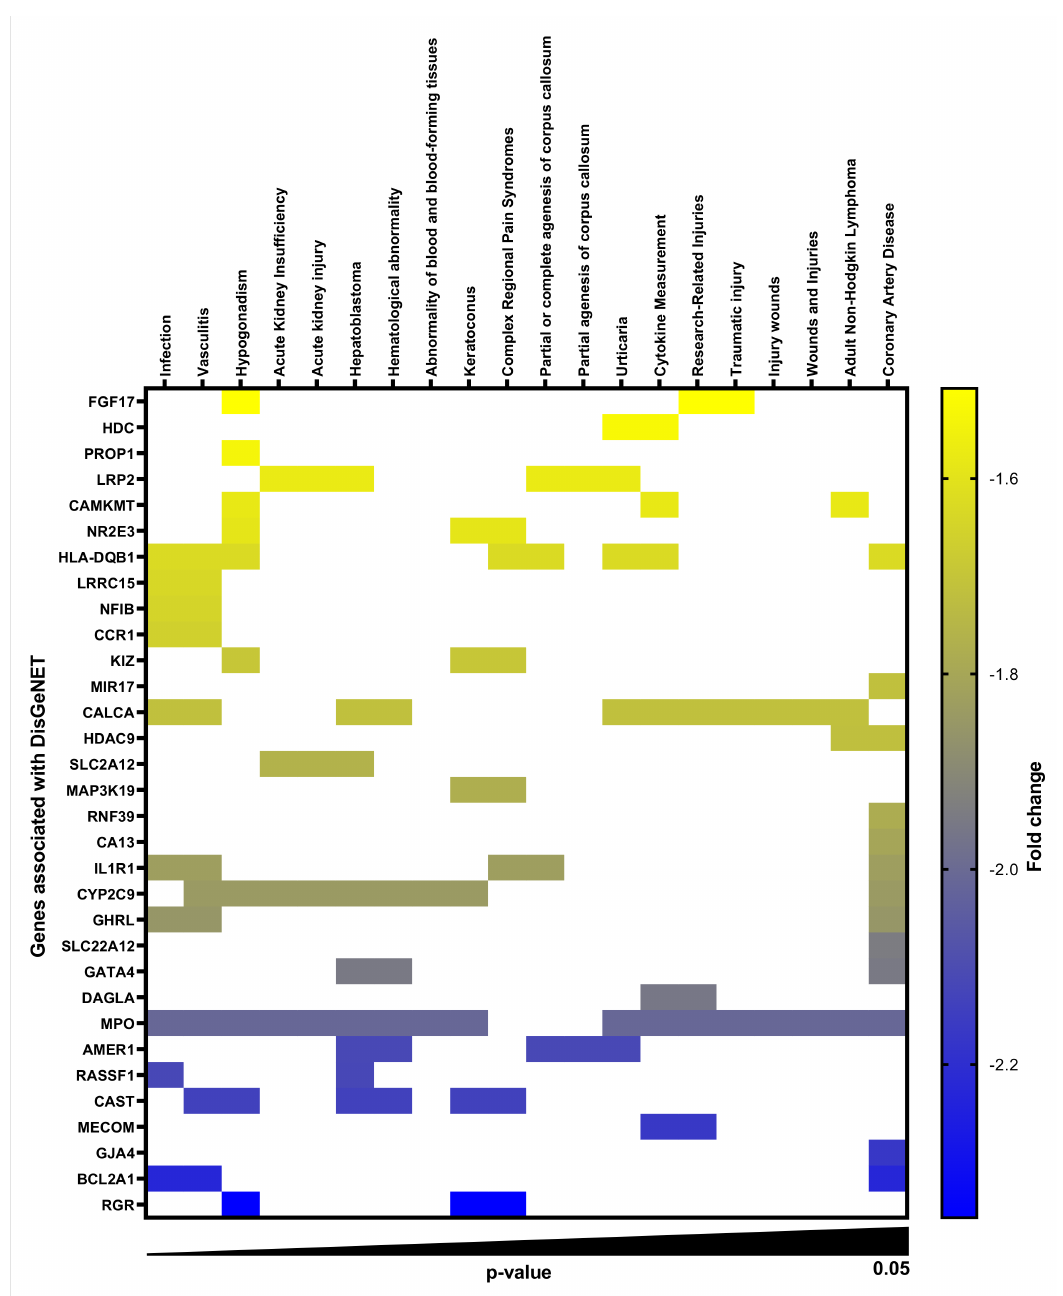
Figure 1. TMAO-downregulated genes in proximal tubular cells with DisGeNET association. Heat map showing the gene-disease association ( p < 0.05) profile of 32 significantly downregulated genes (fold change ≥ 1.5) in proximal tubular cells after 6 h of TMAO 300 µ M stimulation compared to unstimulated cells. Rows represent genes and columns represent DisGeNET